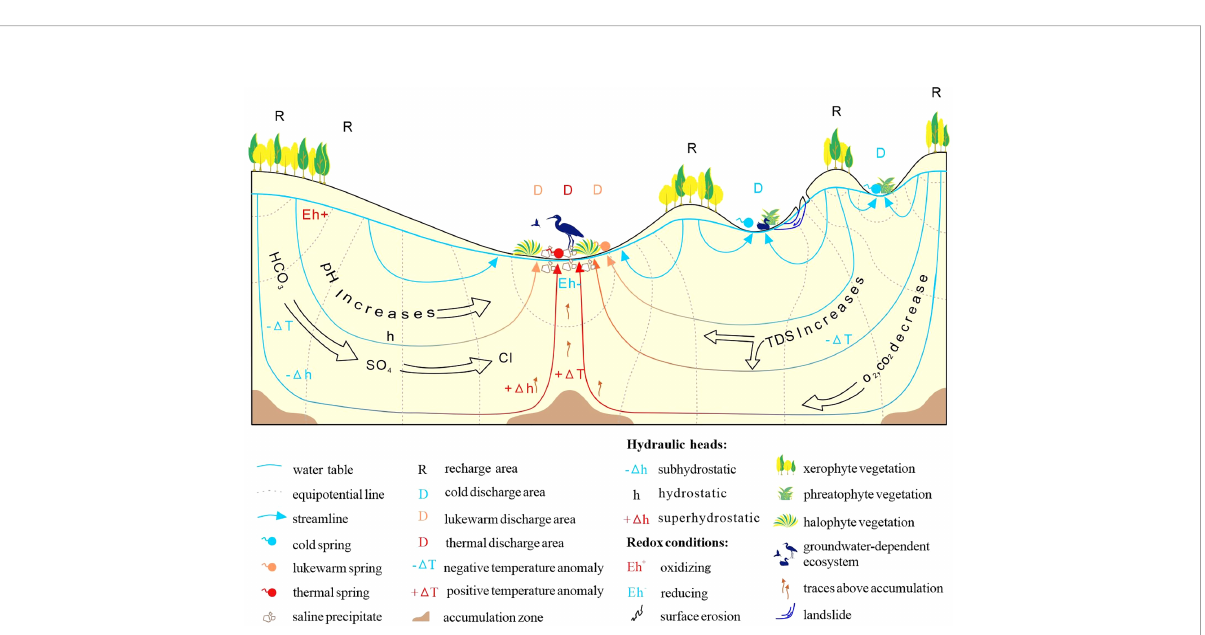
FIGURE 2 Natural conditions and phenomena due to environmental agency of fl owing groundwater in drainage basin (modi fi ed after To ́ th, 1999 and To ́ th, 2016).